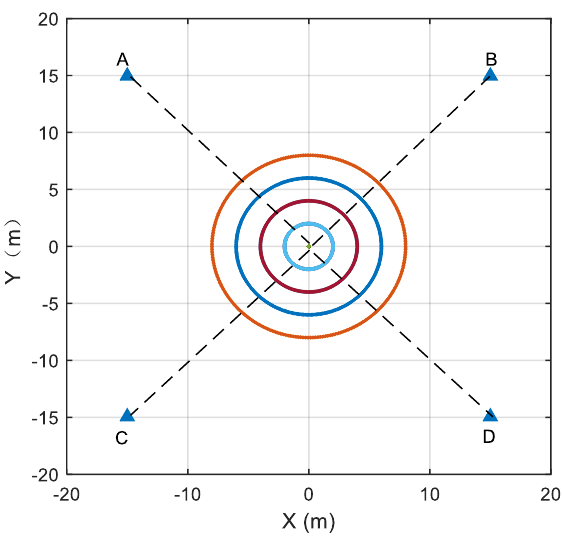
Figure 6. Setup of simulation scenarios.